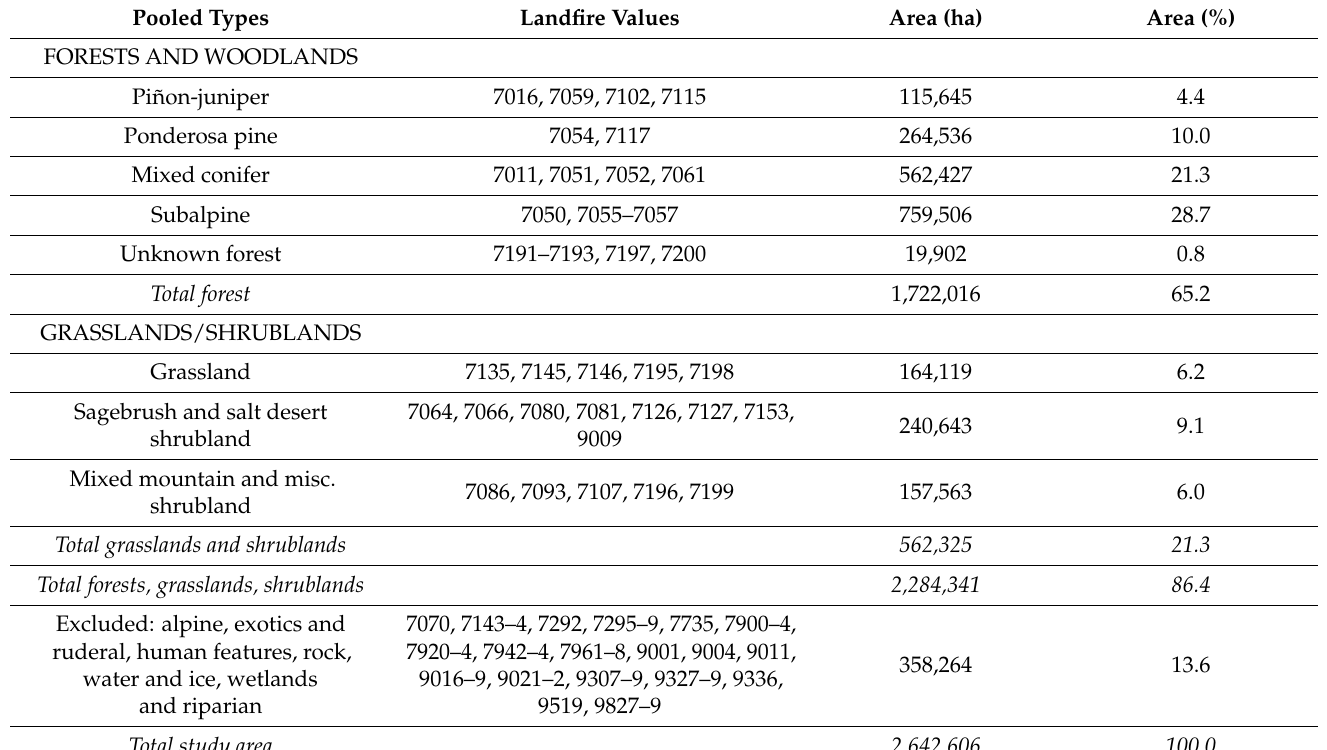
Table 1. Eight pooled ecosystem types in the San Juan Mountains, derived from modern Landfire existing vegetation type (EVT) data ca